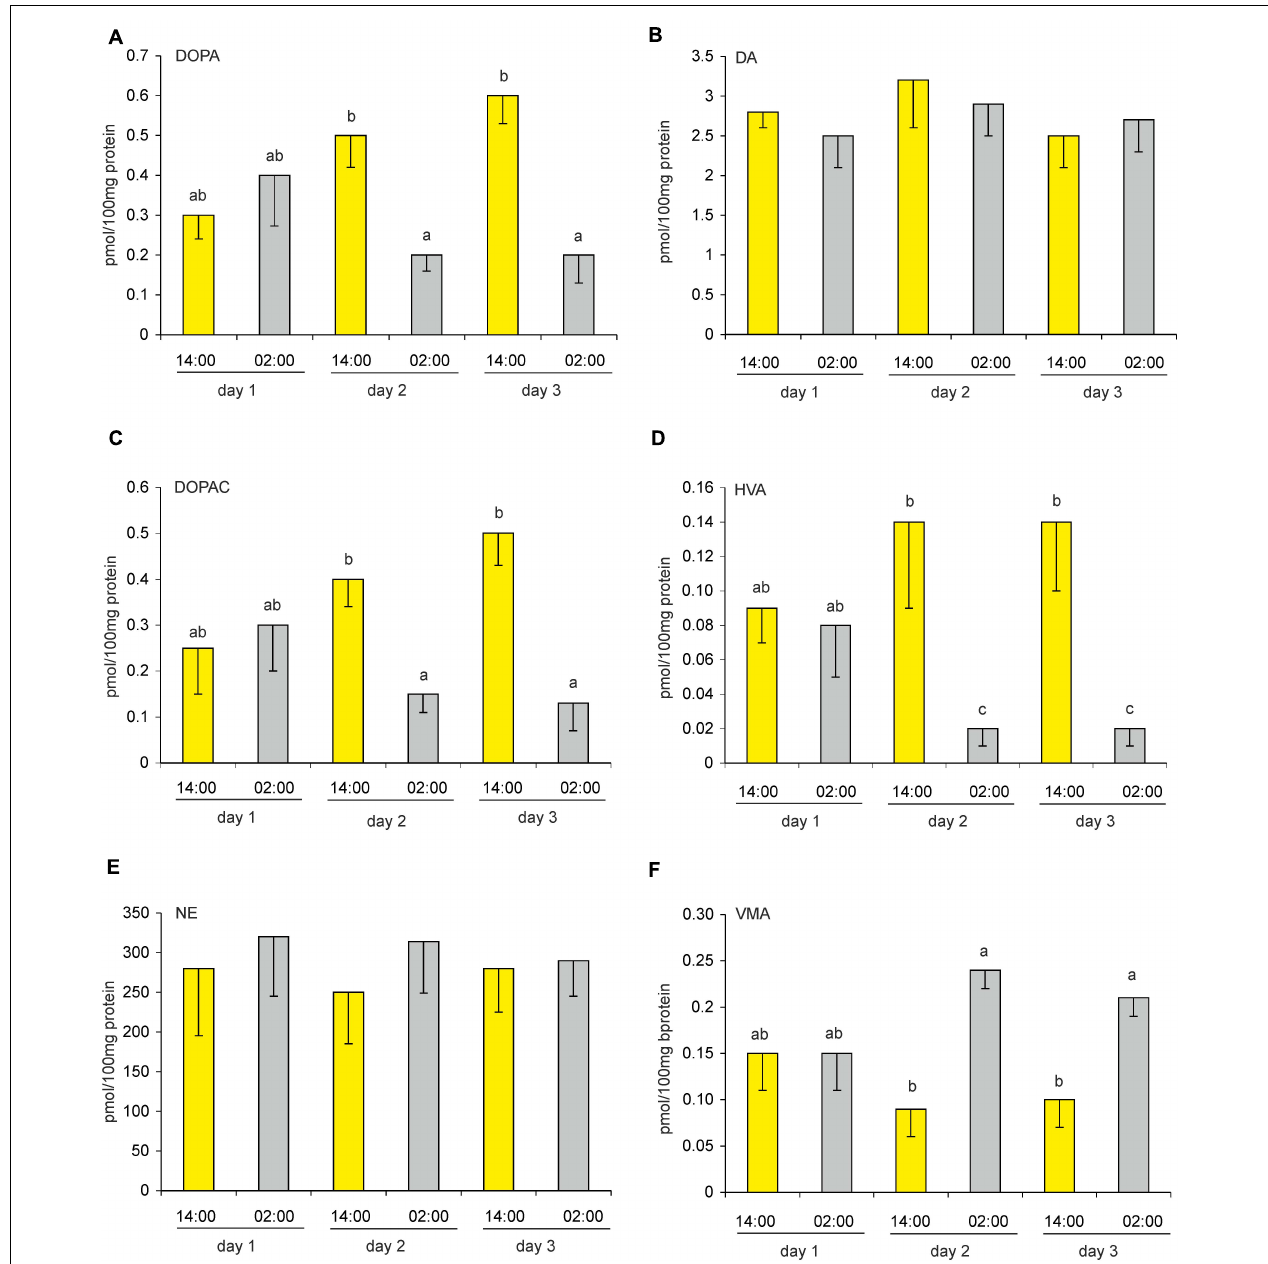
FIGURE 9 | (A–F) Effect of a reversed (dark-light) cycle on catecholamines and their metabolites in goose pineal organs. Geese were kept under revered cycle for 1, 2, or 3 days before DOPA, DA, DOPAC, HVA, NE, and VMA contents were measured. Figures show means and standard errors ( n = 4). Abbreviations and explanations as in Figure 9